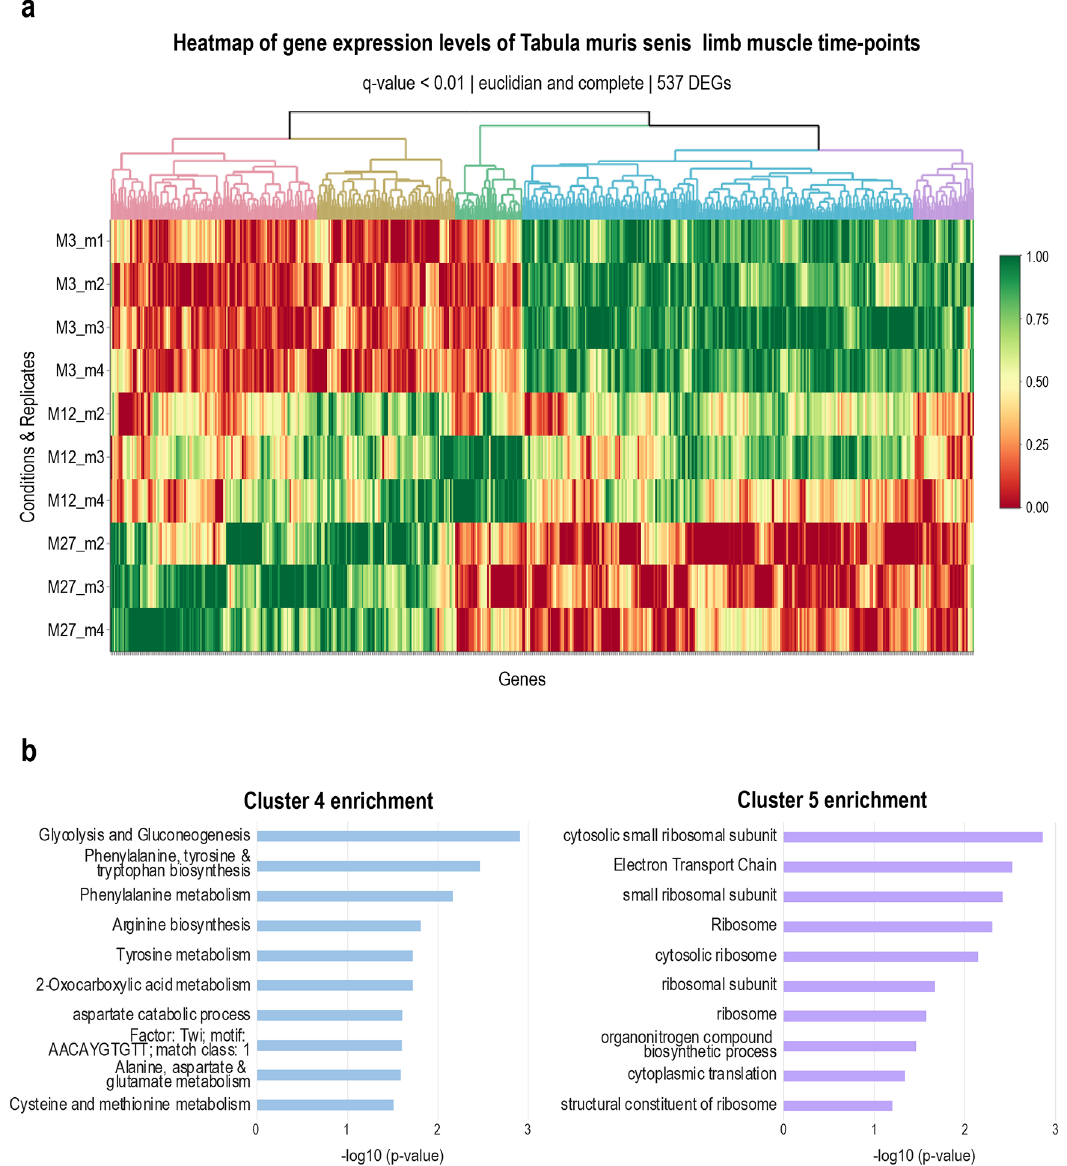
Figure4.Heatmaply clustering ofTabulamurissenislimb muscledata. (a) Heatmapofgeneexpressionlevels of theTabulamurissenislimbmuscledata.Onlysignificantgeneswereselectedforplotting,withanFDRcutoffof0.01, resulting in 624 DEGs. These DEGs could be clustered in 5 independent clusters, indicated by different colours in the dendrogram. (b) Enrichment analysis results for cluster 4 and cluster 5 of the limb muscle heat map. In cluster 4, processesrelatedtoenergyandaminoacidmetabolismareenriched.Genesbelongingtothisprocesshaveahigher expression level in young versus old mice, suggesting more active metabolism in young muscle cells. In cluster 5, processes related to translation are enriched, whereby associated genes have higher expression levels in young muscle versus old muscle. The minus log10 of the p-value of the enriched process is